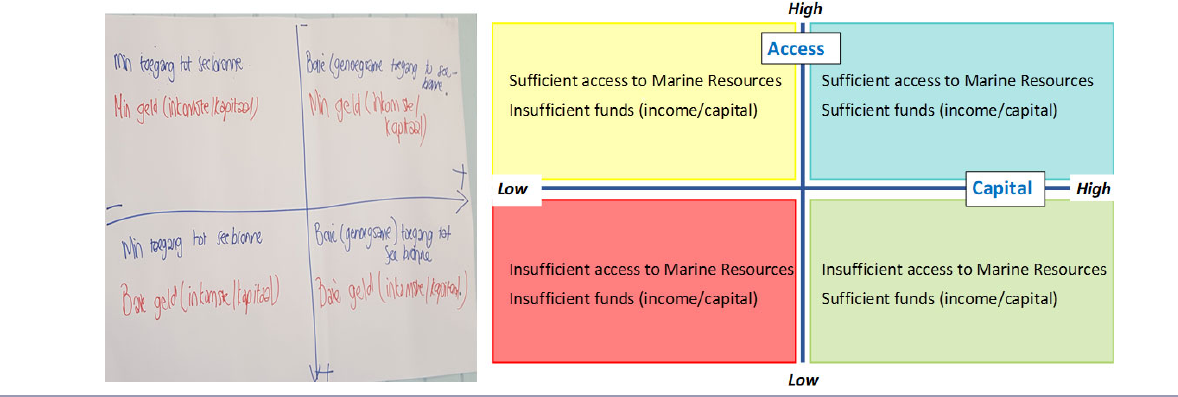
Fig. 5 . Key driving forces (KDFs) identified by participants. Access to marine resources and access to capital (funds) were identified as the two most important driving forces when considering the ability to attain a sustainable fishery-derived income. On the left, the possible scenarios and states are shown as determined in Workshop One, the right panel shows the same drivers and states in English, and on a standard Cartesian